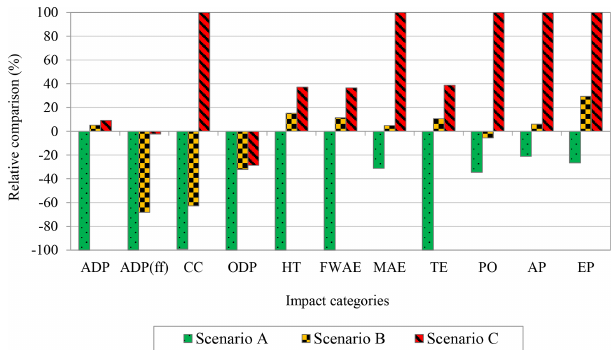
Figure 2. Environmental impact of AD-pyrolysis scenarios: relative comparison among the three alternative biogas